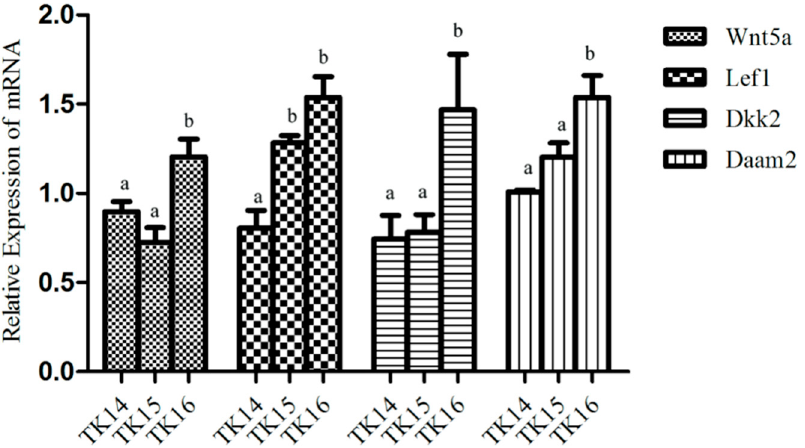
Figure 9. The expression of Wnts in CR tissues from TK14 to TK16 were detected by qRT-PCR. The mean values sharing different superscripts are significant different ( p < 0.05).